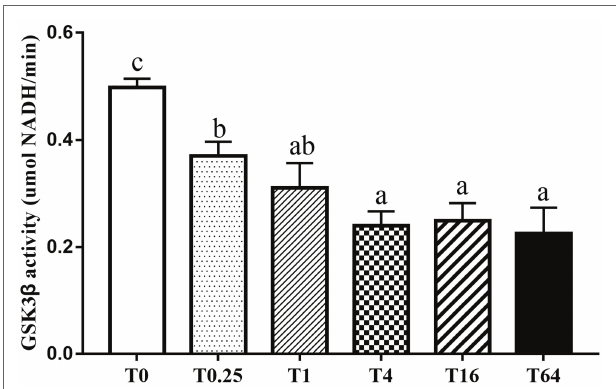
FIGURE 1 | Influence of dietary TWS119 on the enzyme activities of LvGSK3 β in P. vannamei . The detection of enzyme activities was performed in triplicate for each sample. Values (means ± SD) with different letter mean significant difference ( p <